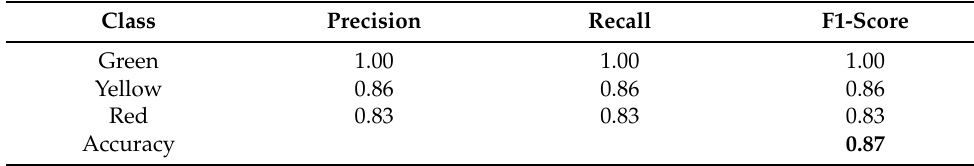
Table 8. Classification report for the RF